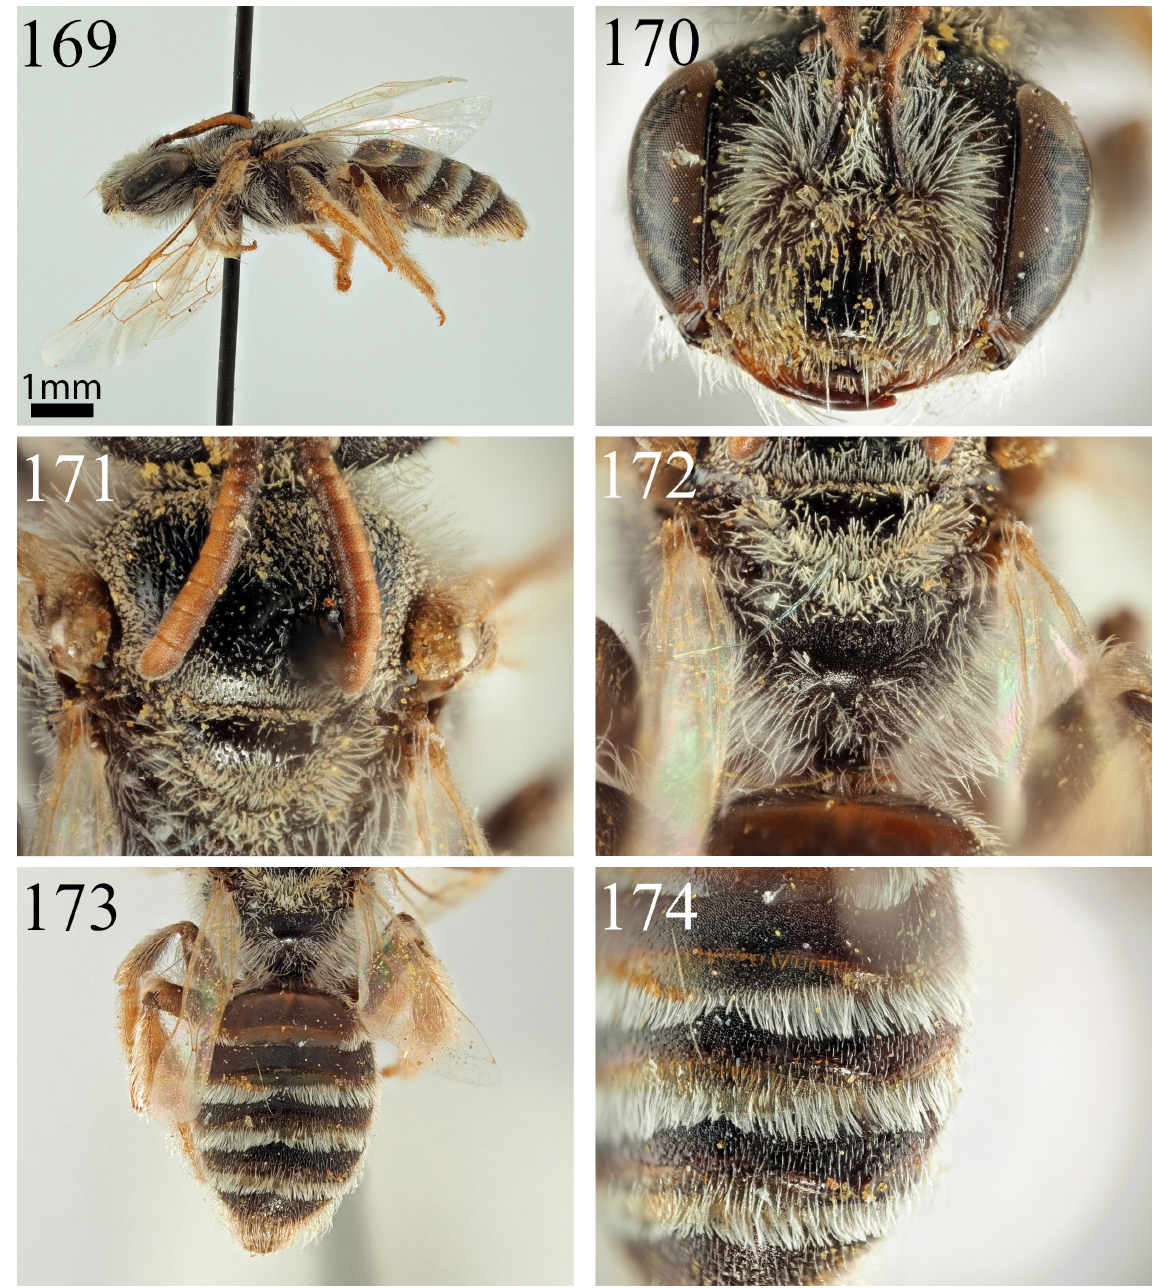
Figs 169–174. Andrena nitidicollis Morawitz, 1876, ♀ (OÖLM). 169 . Profile. 170 . Face. 171 . Scutum. 172 . Propodeum. 173 . Terga. 174 .